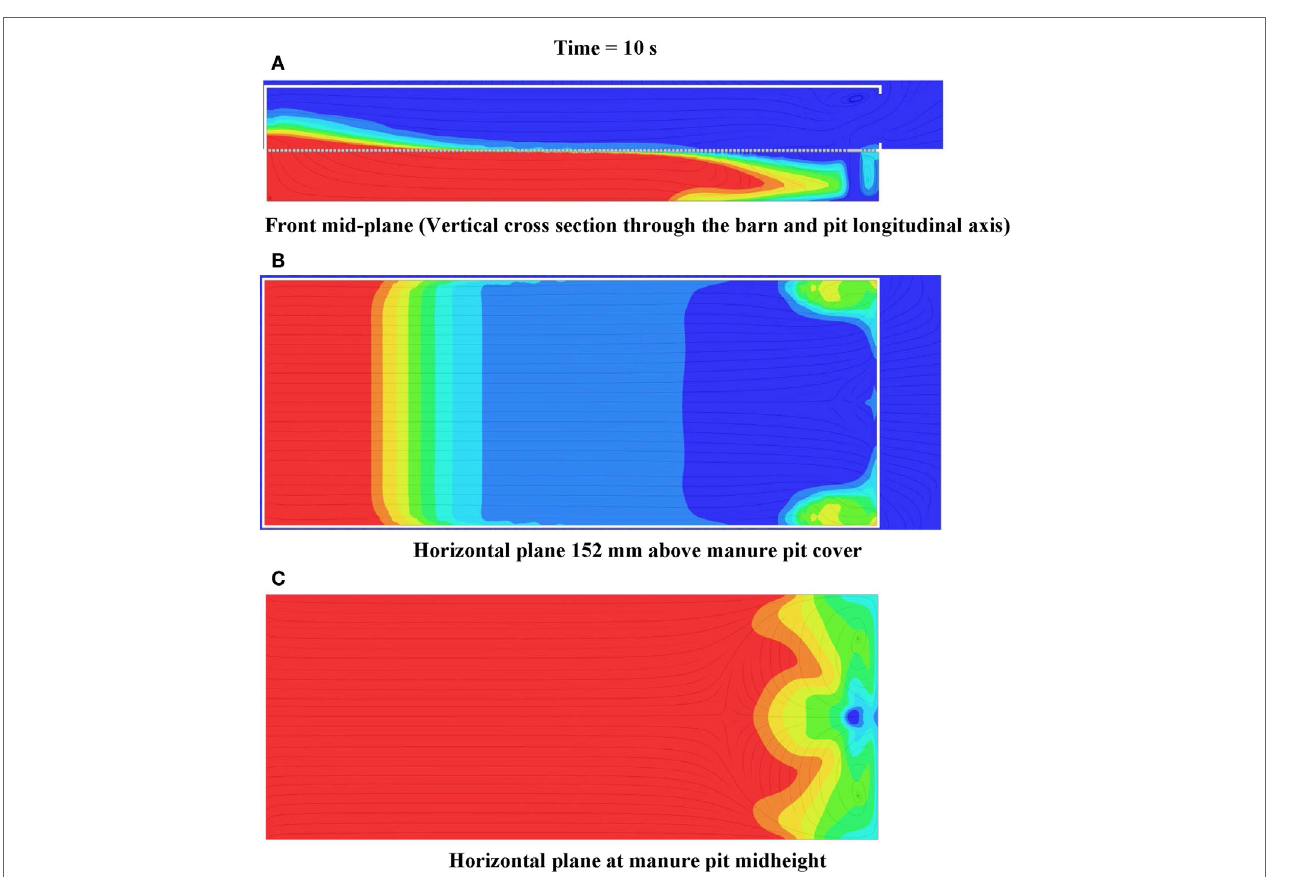
FIgURe 12 | Frames of (A) front mid-plane, (B) horizontal plane 152 mm above manure pit cover, and (c) horizontal plane at manure pit mid-height cut plot animations of hydrogen sulfide concentration 10 s after commencement of pit ventilation for case Study 1: tunnel ventilated (parallel flow) barn above slotted-covered manure pit (see Figure 11 for color legend for hydrogen sulfide) .